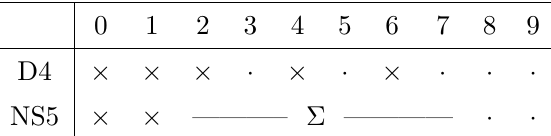
———– Σ ———— · Table 3 . Brane brick models are Type IIA configurations where D4-branes are suspended from an NS5-brane that wraps a holomorphic surface Σ . This configuration is T-dual to the D1-brane probing the toric Calabi-Yau 4-fold corresponding to Σ